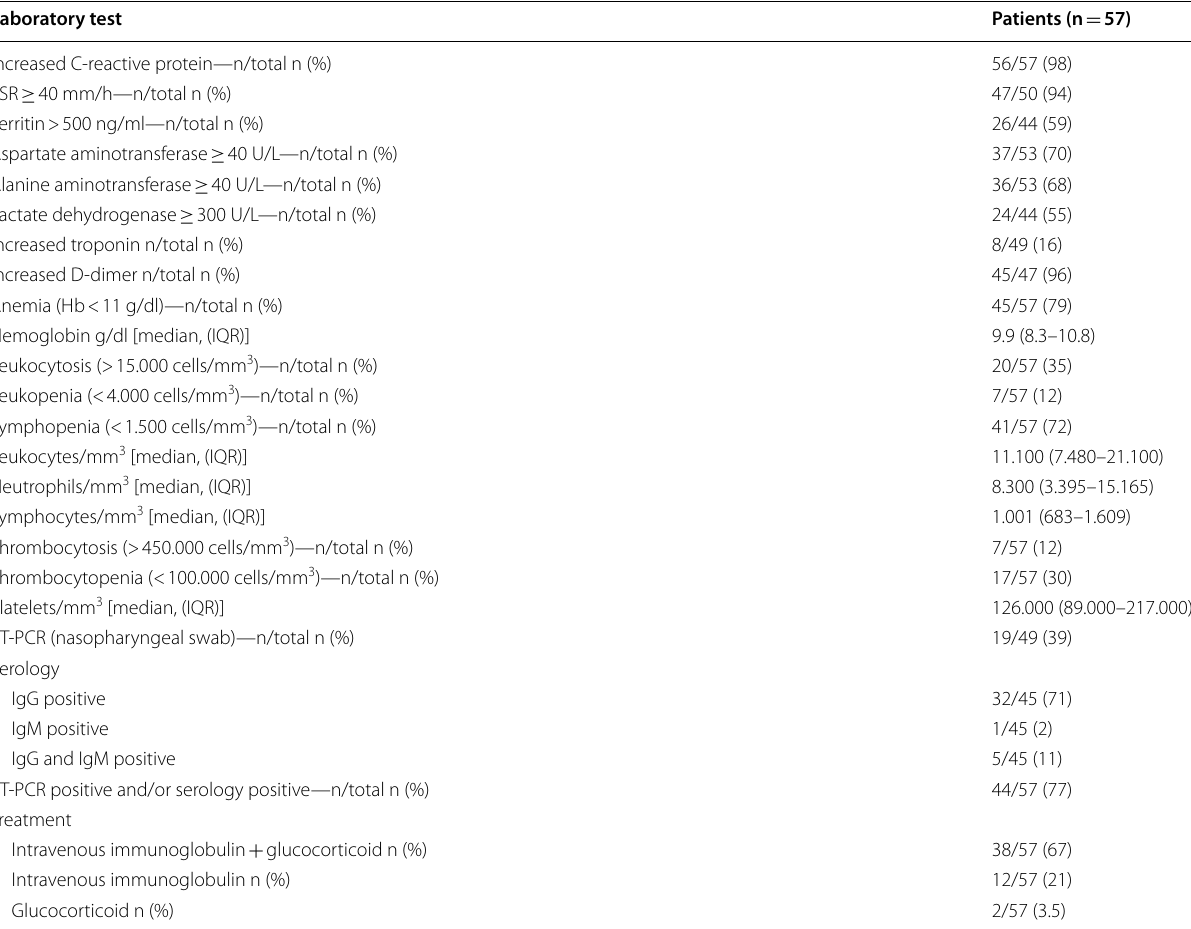
Table 2 Laboratory tests and treatment of patients with paediatric inflammatory multisystem syndrome temporally associated